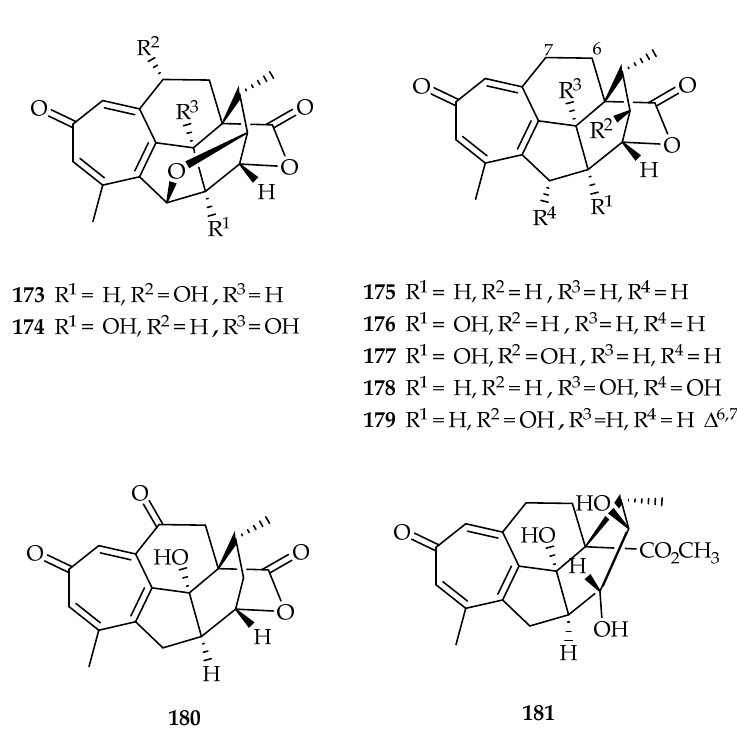
Figure 73. Structures of cephinoids F-L 173–179 [113] and N-O 180–181